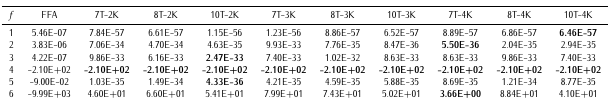
Table 6. Results: 40 fireflies and Crossover with the K best threads